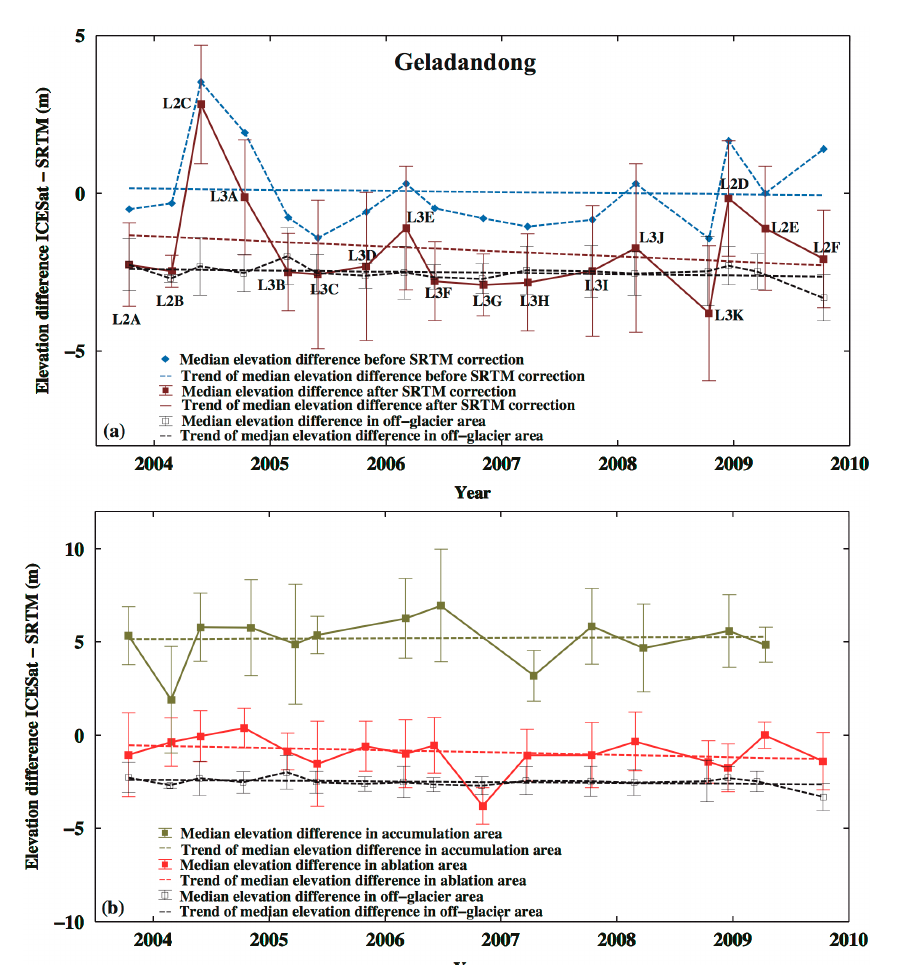
Figure 4. ( a ) Glacier elevation changes and the estimated rates for the entire Geladandong (red box). Rates are determined using all median values of elevation differences between ICESat and SRTM over ICESat footprints (Section 2.3). The rates are determined in ( a ) the entire glacier area (marked with ICESat cycles) using corrected and uncorrected SRTM elevations and ( b ) in the accumulation and ablation areas using corrected SRTM elevations.